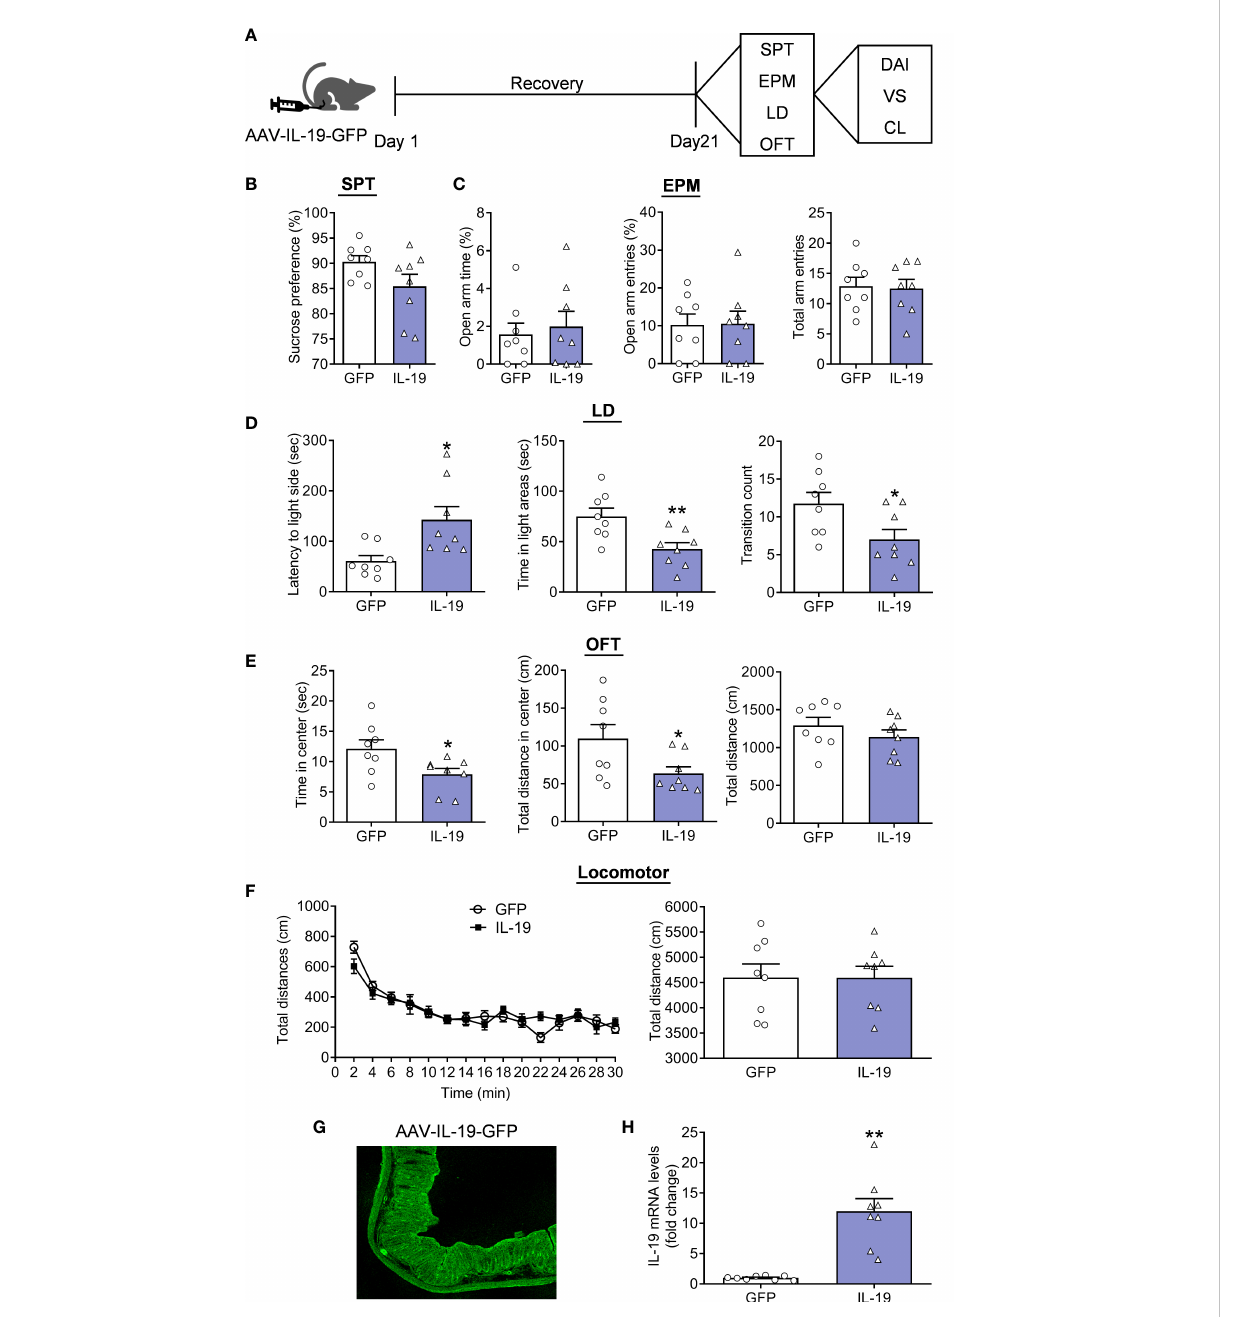
=11.9100, p <0.0010). Furthermore, we veri fi ed the IL-19 overexpression signi fi cantly reduced the expression of p-ERK ( p <0.0010) and p-CREB ( p <0.0010) in the hippocampus of CUS/ DSS treated mice (Figure 8D, p-ERK: F(2,18)=38.3100, p <0.0010; Figure 8E, p-CREB: F(2,18)=51.7400, p <0.0010).